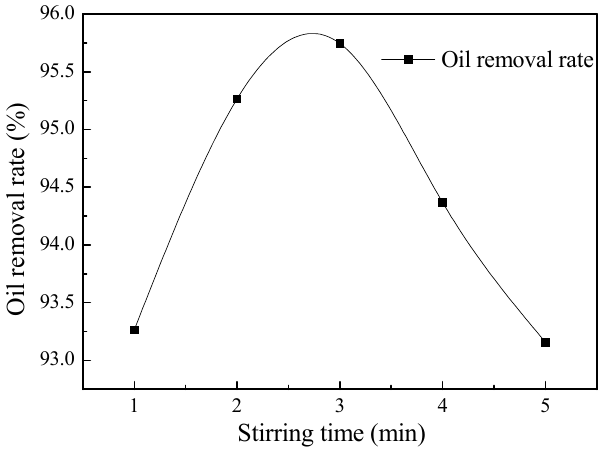
Figure 8. E ff ect of stirring time on oil removal Figure 8. Effect of stirring time on oil removal rate.